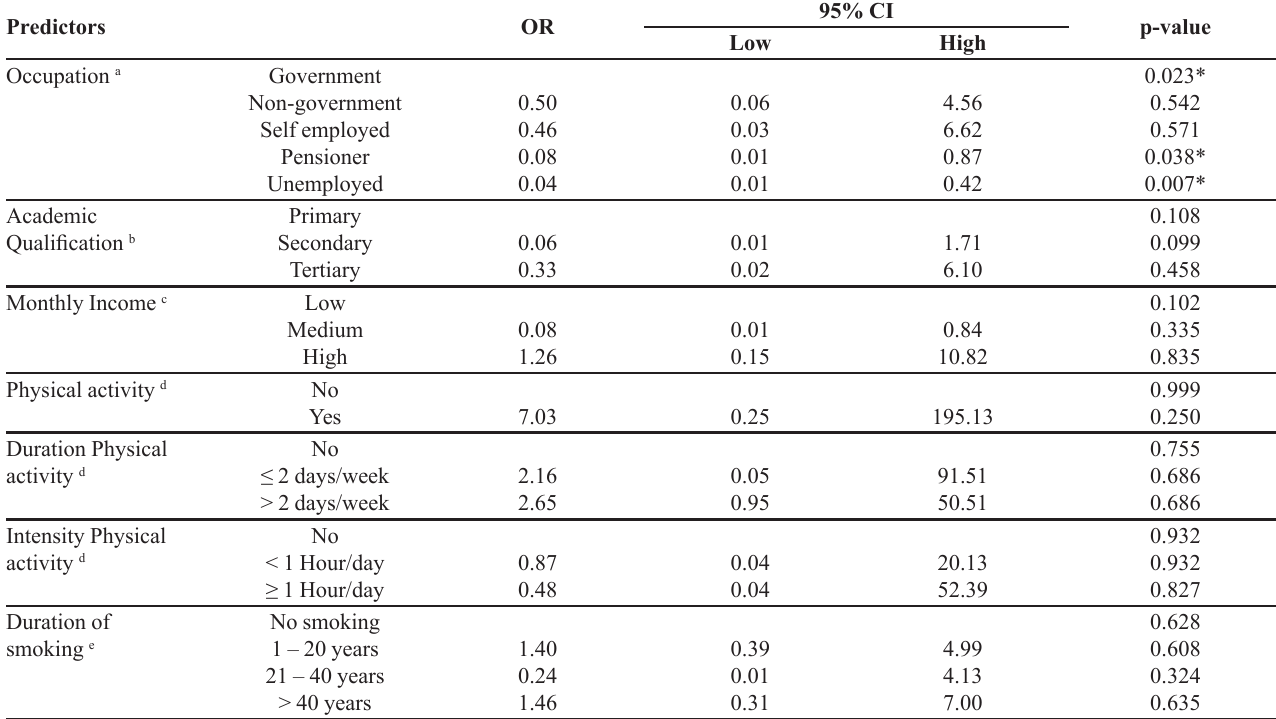
TABLE IV - Predictors of Total Testosterone Level (Binary Logistic Regression – Factors Associated with TT level)